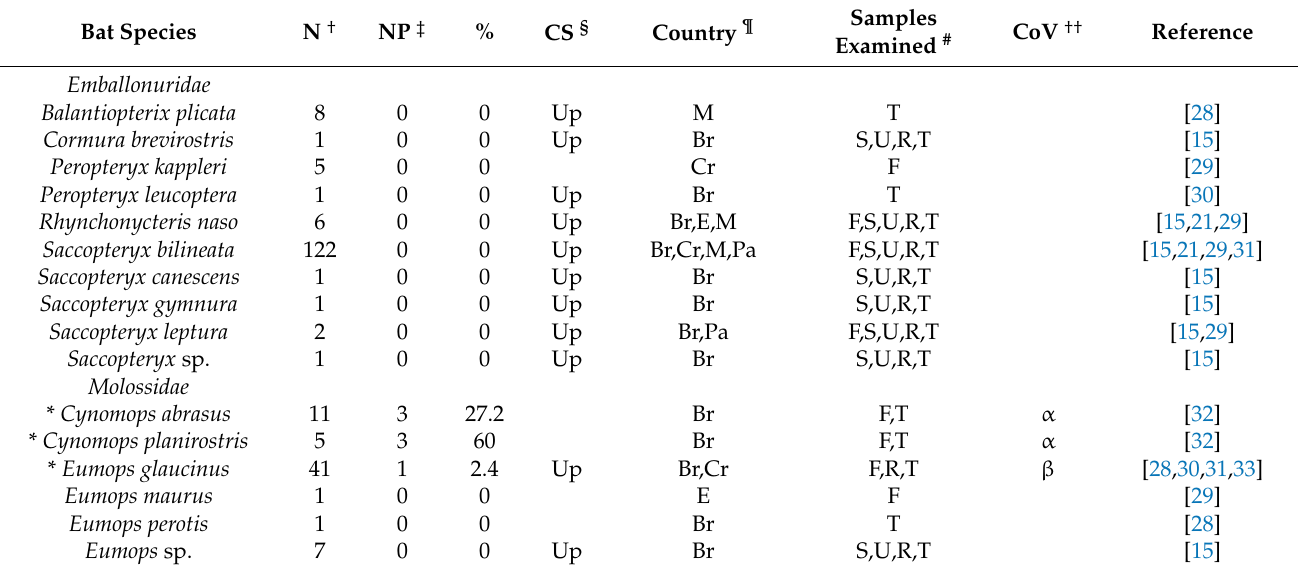
Table 1. Bat species in which natural coronavirus infection has been explored in the Americas. Bat Species